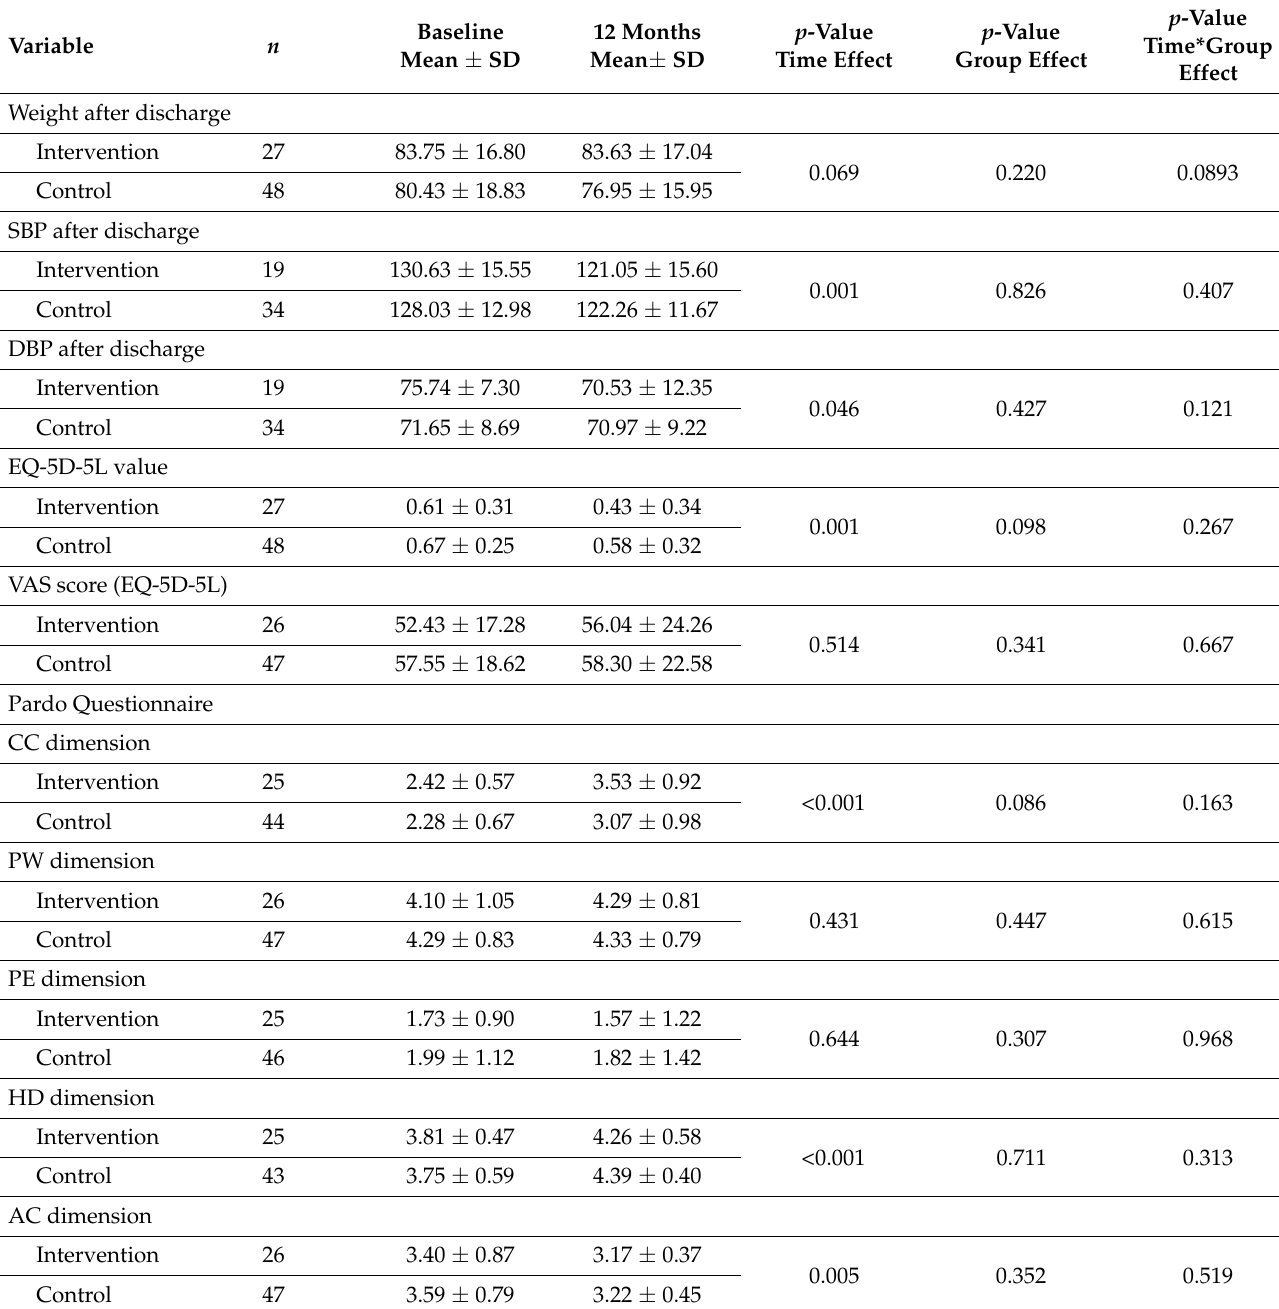
Table 7. CCI ≥ 3. Comparison between baseline and 12 months ( n =